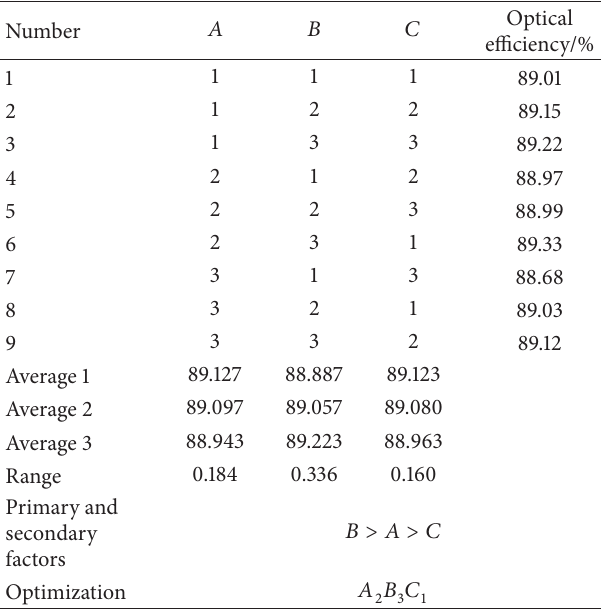
Table 3: The orthogonal experimental results of optical efficiency on cavity